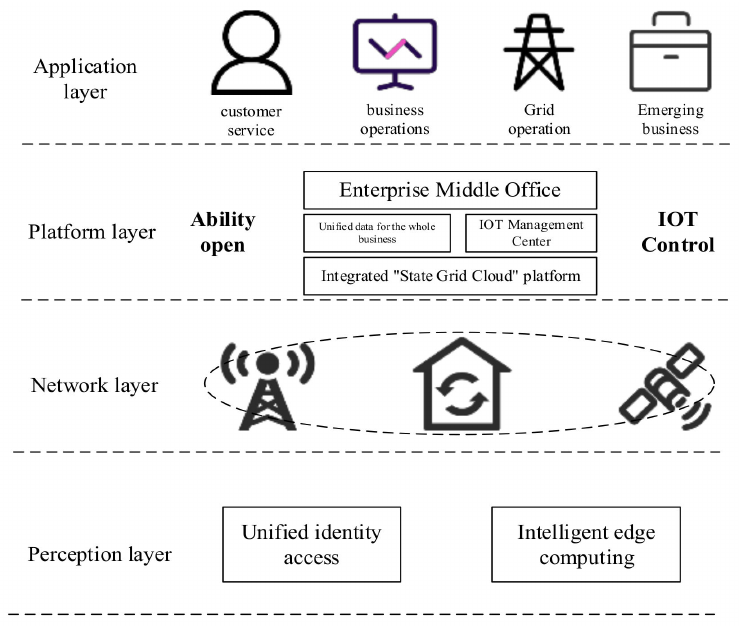
Figure 1. Smart grid network